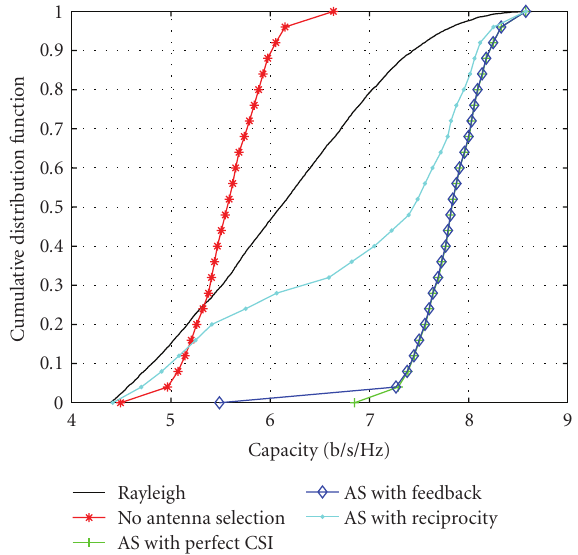
Figure 10: The cumulative distribution function of capacity at Location 5.